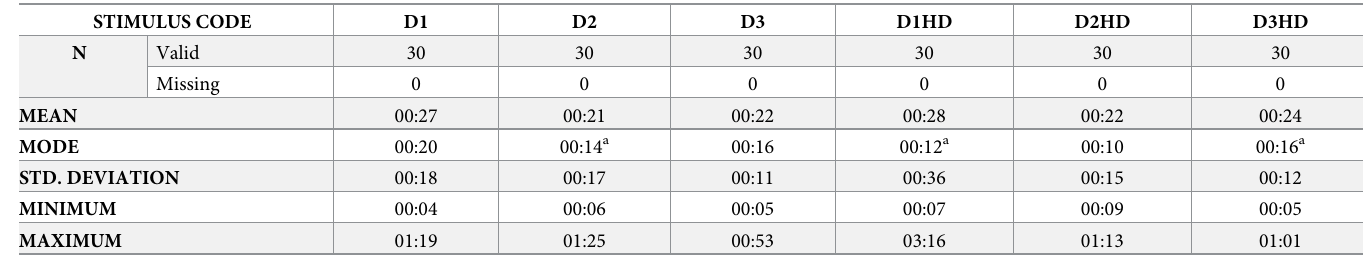
Table 6. Task 2 statistics.